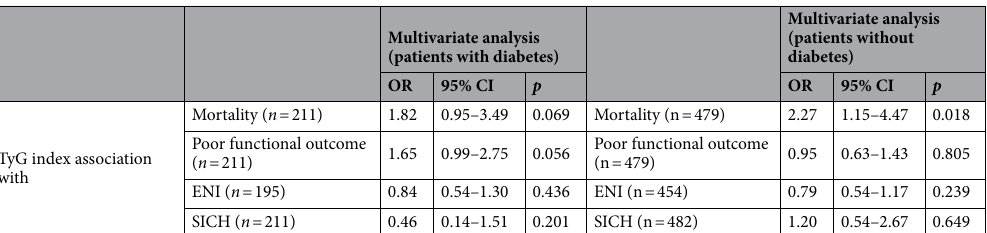
Table 5. Association of TyG index with outcomes in patients with and without diabetes. Adjusted odds ratio, 95% confidence interval and p-value calculated from logistic regression after adjusting for adjusting for hypertension, age, admitting NIHSS and LVO status. n number, OR odds ratio, 95% CI 95% confidence interval, p p-value, TyG index triglyceride-glucose index, ENI early neurological improvement, SICH symptomatic intracranial